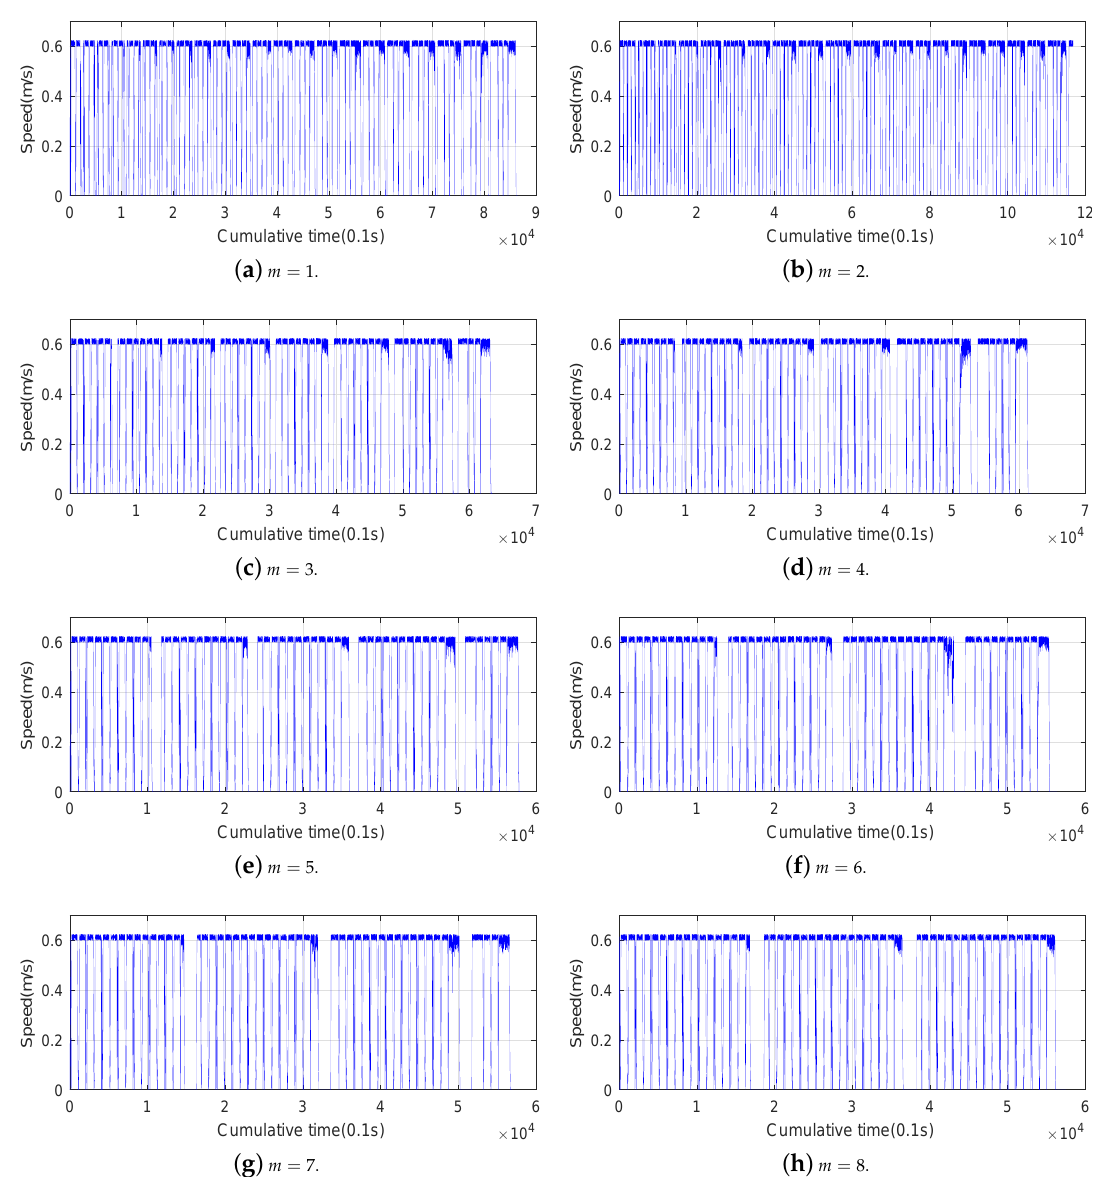
Figure 14. Comparison of working speed under different load factor m .